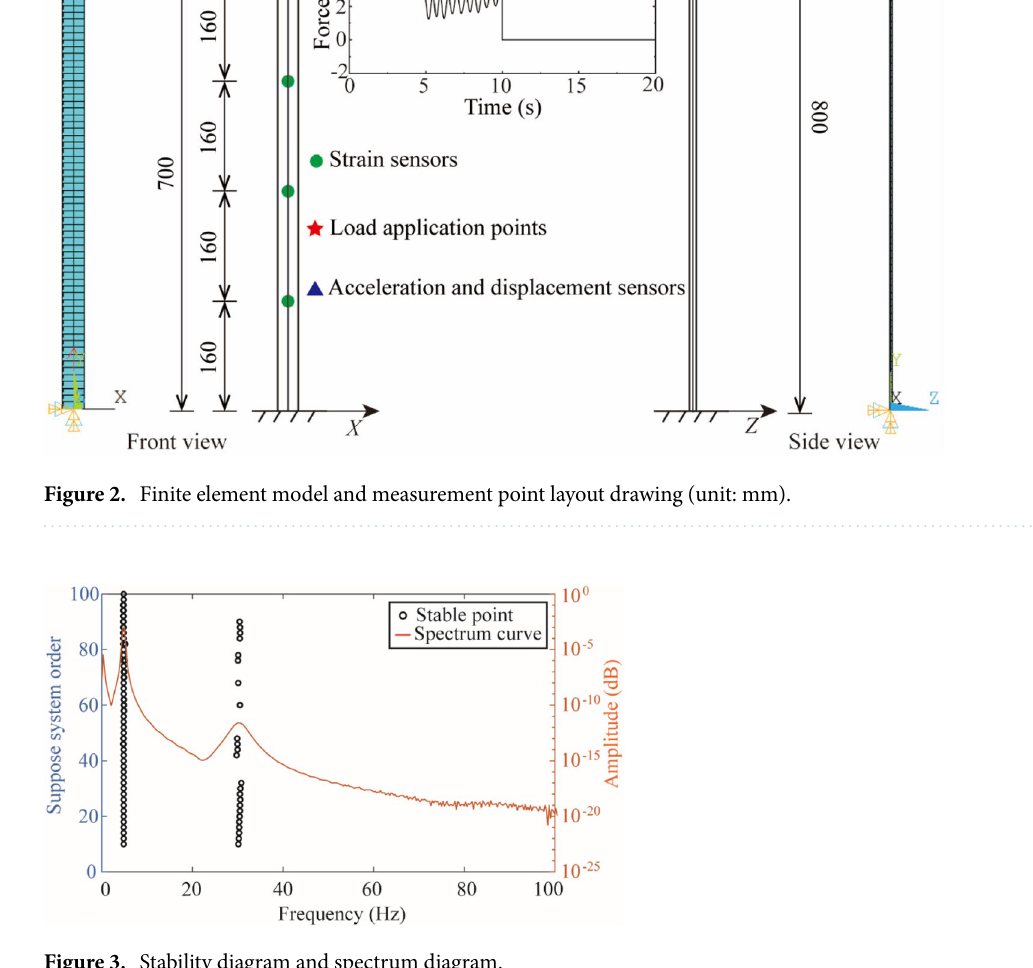
Fig. 3. The circles in the stability diagram represent the points where the modal parameters have stable solutions and the orange curve represents the spectrum curve. Considering the stable axis and the spectrogram comprehensively, the first two-order strain modes occupy most of the vibration energy clearly, so only the first two-order strain modes are extracted, and they are compared with the strain mode shapes extracted by ANSYS and that calculated by the method proposed by Wang et al. 17 as shown in Fig. 4. The calculated results of proposed method are closer to the theoretical value whether the first-order or second-order mode, indicating the superiority of the proposed method. According to the mode superposition method, the displacement mode can be calculated from the strain mode and the low sampling rate dynamic displacement was obtained, then the proposed multi-rate Kalman filtering algorithm was used to reconstruct the displacement. In addition, the displacement reconstruction method proposed by Zhu et al. 26 was used for comparison, the measurement points required by this method are 0 m, 0.27 m, 0.54 m and 0.8 m away from the fixed end. The strain data on both the left and right sides for each measurement point are needed to be extracted to calculate the strain difference, which means there are eight strain sensors. The method has established the mapping relationship between strain difference on both sides and displacement of the same measuring point, so the strain sensor must be arranged at the target measuring point. Nevertheless, the method proposed in this paper fits the function relation between the mode shape value and the corresponding height value. Even if the strain sensor is not installed at the target point, the height of the target can be substituted into the mode shape function to obtain the mode shape value, and then the dynamic displacement can be obtained. The schematic diagram of the measurement points layout and parameters is shown in Fig. 5. The unit virtual force is applied at the target point.